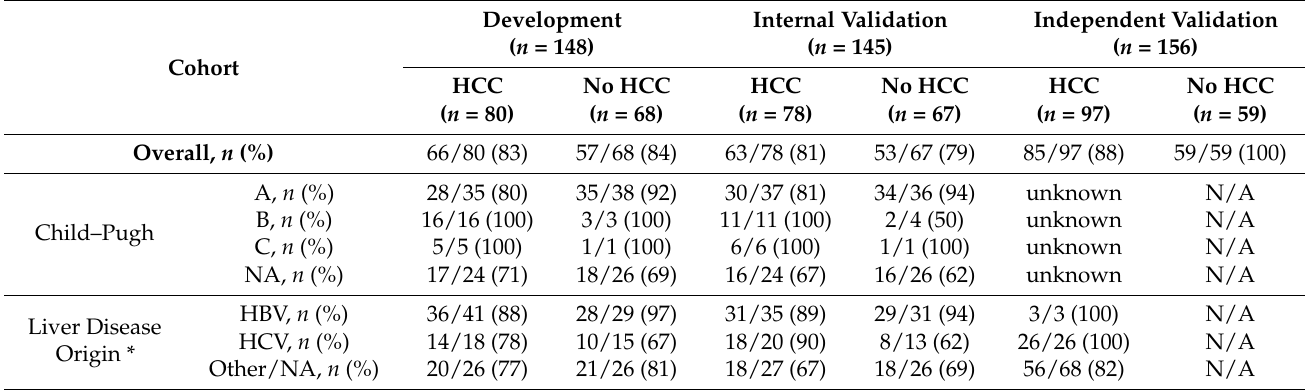
Table 2. Accuracy of the test overall and by clinical subgroups depending on liver function and origin of the disease.